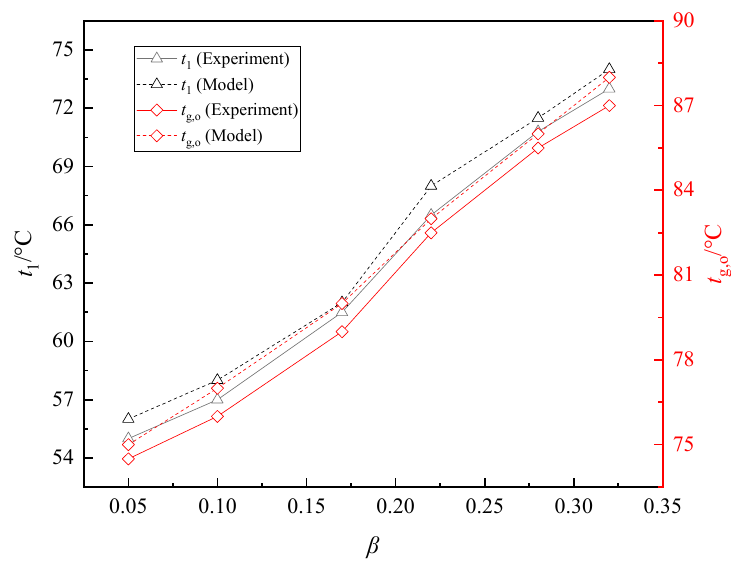
Figure 20. Relationship between β and t g,o , t 1 .